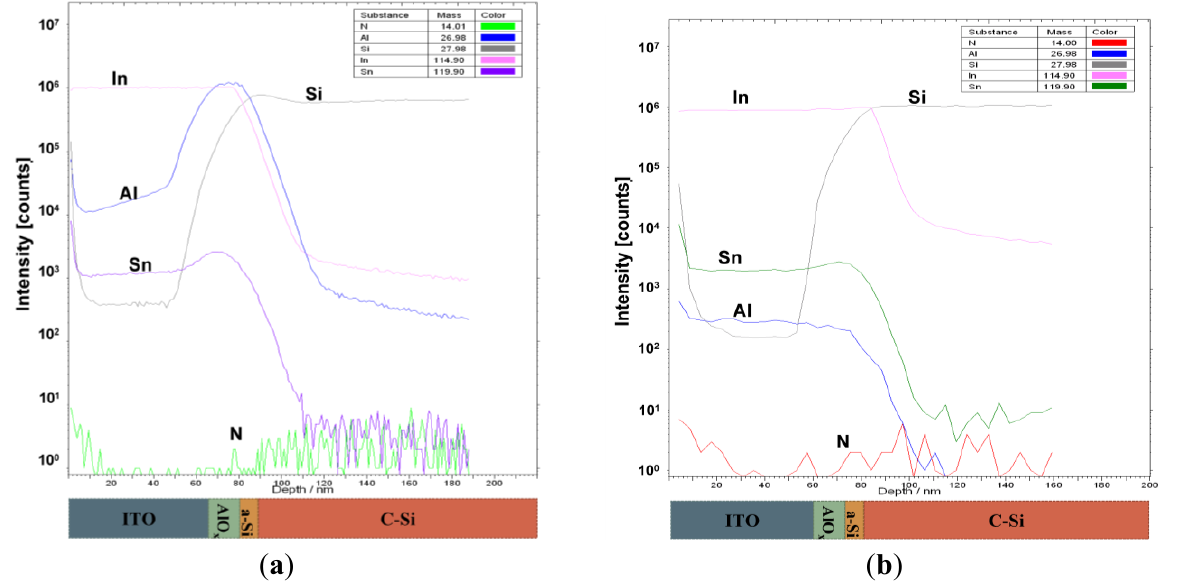
Figure 7. ( a ) The SIMS profiles of PIII 4KeV sample. ( b ) The SIMS profiles of PIII 2 KeV